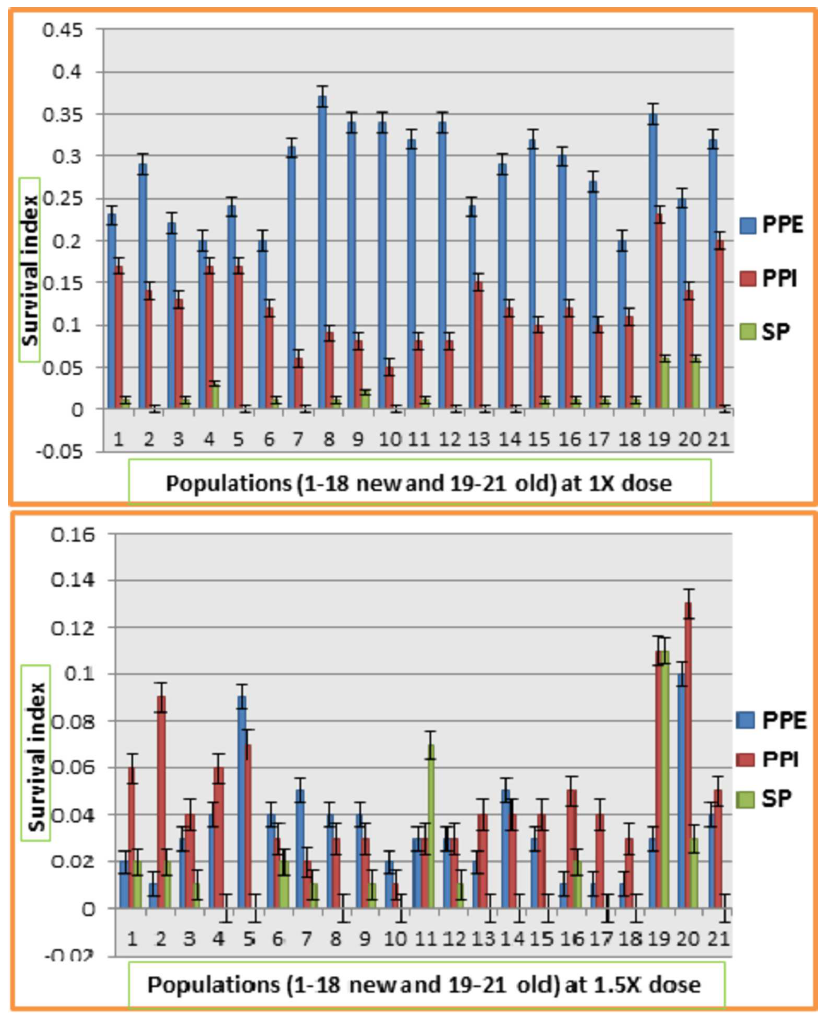
Fig 3. Response of 21 populations of lentil for survival index at different doses of Atlantis at three different screening methods.